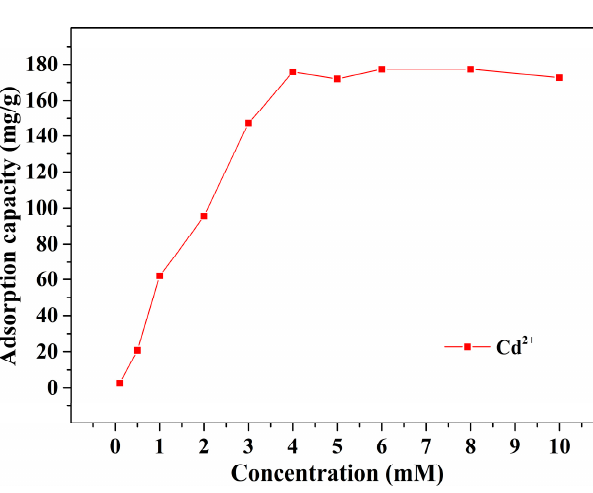
Figure 9. The maximum adsorption capacity of Alg-EDTA for Cd 2+ . Table 3. The adsorption capacity of Alg-EDTA for heavy metal ions.